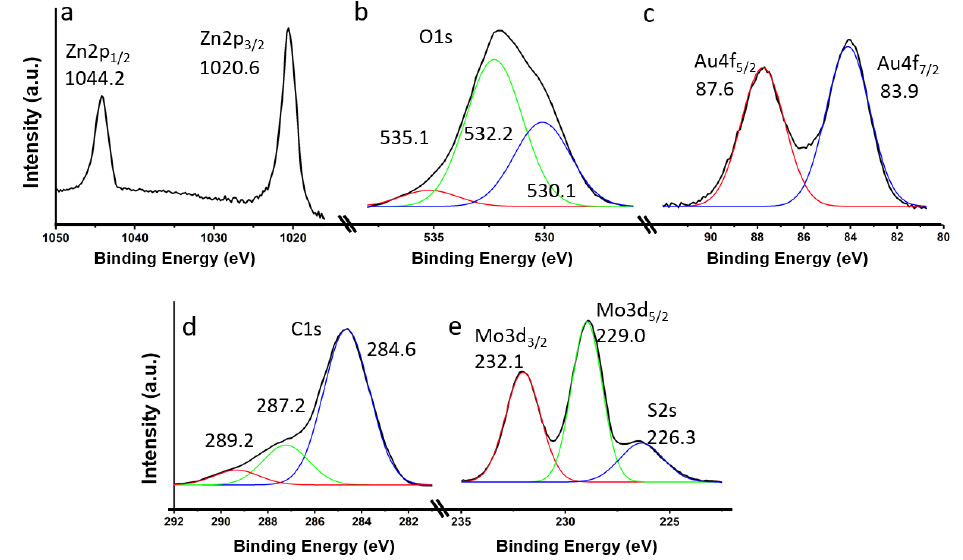
Figure 5. XPS core level spectra for 5%Au@ZnONPs-3%MoS 2 -1%rGO: Zn2p ( a ); O1s ( b ); Au4f ( c ); C1s ( d ); and Mo3d-S2s ( e ). C1s ( d ); and Mo3d-S2s ( e ).